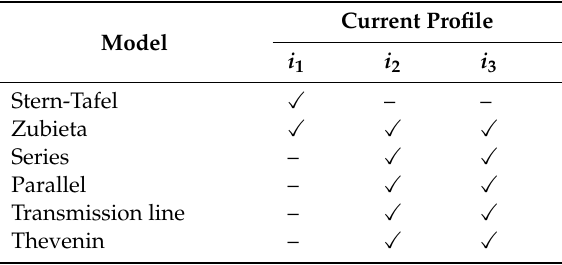
Table 3. Identification Current Profiles Used to Supercapacitor Parameters Estimation.